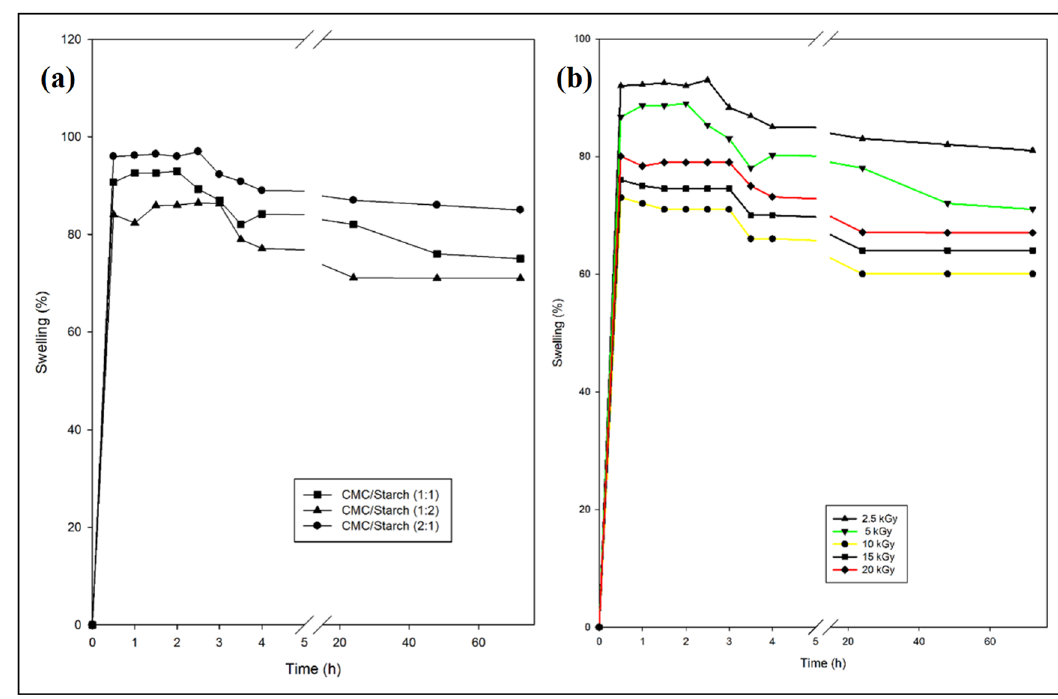
Figure 5: Swelling behaviour of CMC/starch blend at ( a ) di ff erent compositions and ( b ) di ff erent irradiation doses of selected CMC/starch ( 1:2 )